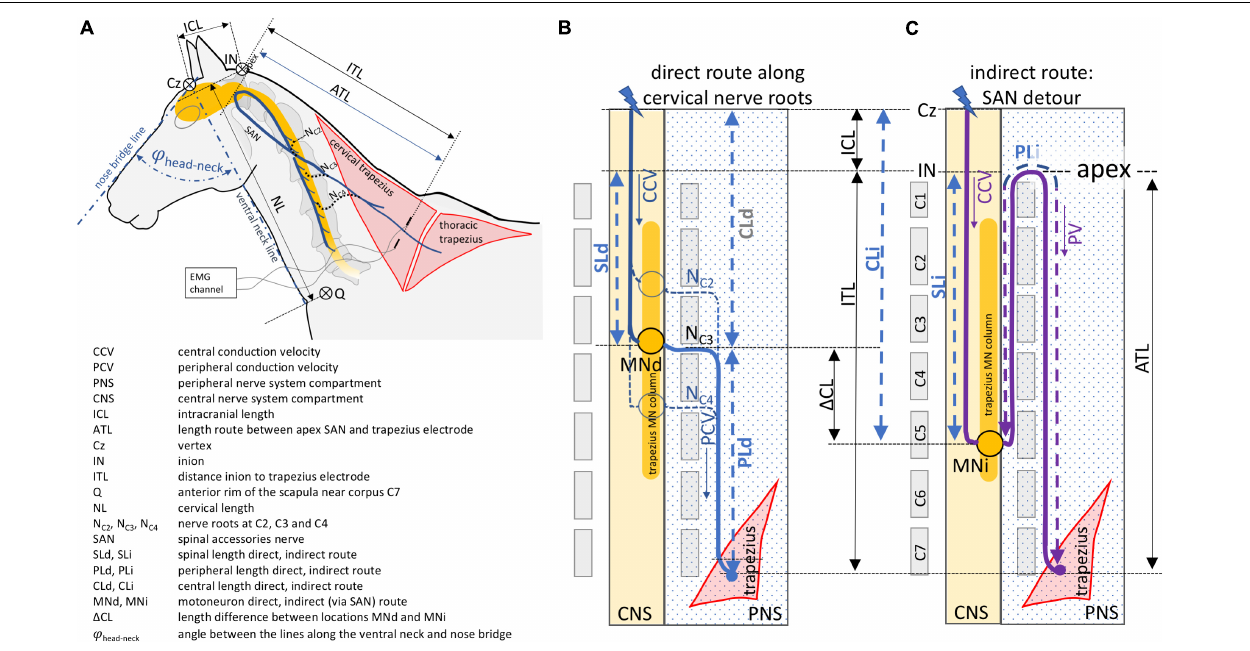
FIGURE 1 | Schematic overview of the direct (B) and indirect (C) neuroanatomic pathways between transcranial stimulation and recording electrodes inserted into the trapezius muscle. The direct route courses along three cervical nerves and the indirect route via the spinal accessory nerve. The neuroanatomy and definitions of geometric measures and symbols are illustrated and explained in panel (A)